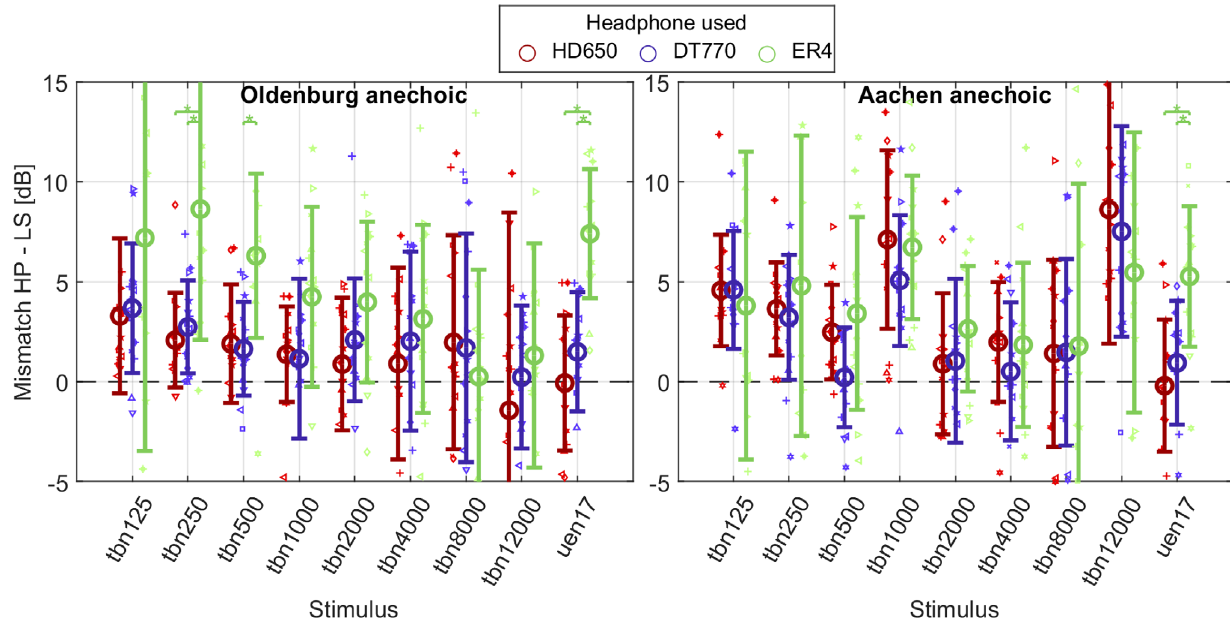
Figure 5. Level mismatch obtained from the loudness balancing tests between headphone and loudspeaker presentation for three headphones and 14 subjects across two sites. Each smaller marker is the mean for one participant, each bigger marker the mean over all participants with the whisker indicating the standard deviation. The results are plotted as eardrum sound pressure level difference between headphone and loudspeaker presentation for the same perceived loudness. The x -axis denotes the presented stimulus and the fi gure is split into the two tested rooms. Each colour represents one speci fi c headphone